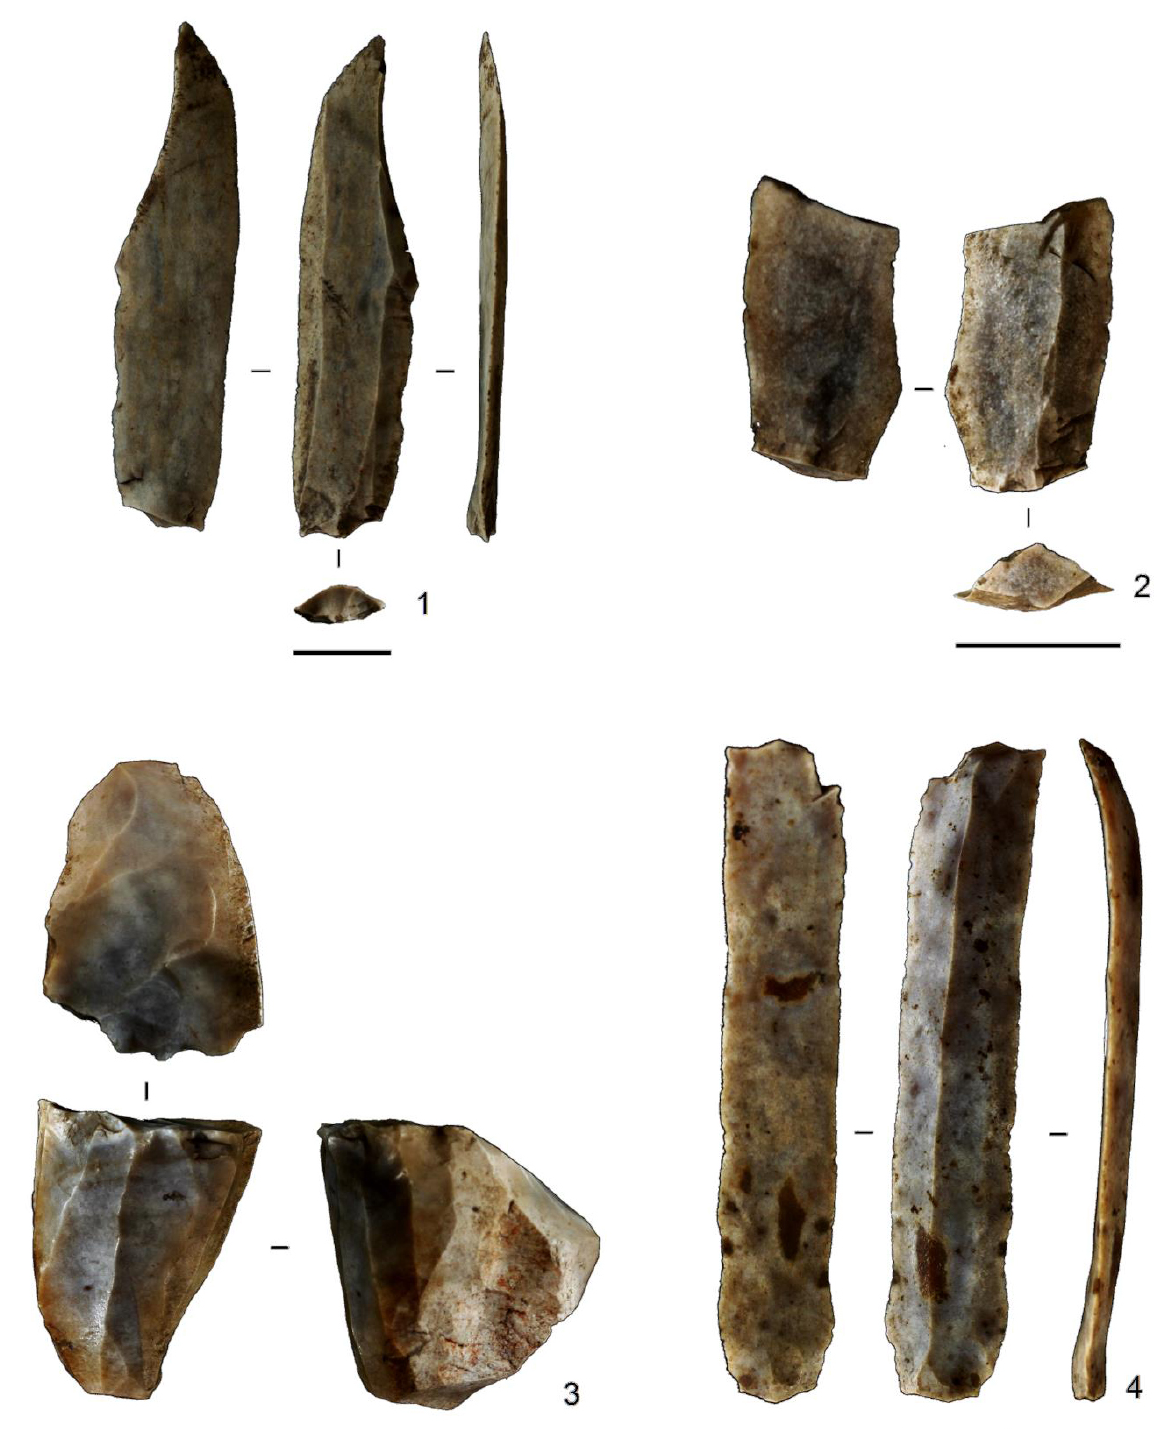
Figura 5. Exemplos de núcleo e lamelas do Meu Jardim. 1. 1: lamela inteira com talão diedro (Sondagem 1, Fase III); 2: lamela de fratura proximal com talão liso (Sondagem 1, Fase III); 3: núcleo prismático para lamelas com plataforma facetada (Sondagem 3, UE 3030, Fase IV); 4: lamela inteira, não retocada, de talão liso (Sondagem 3, Fase II). (barras = 1 cm). Figure 5. Examples of core and bladelets from Meu Jardim: 1: complete bladelet with dihedral butt (Test 1, Phase III); 2: proximal bladelet with flat butt (Test 1, Phase III); 3: prismatic core for bladelet production, with facetted platform (Test 3, Phase IV); 4: complete bladelet, unretouched, with flat butt (Test 3, Phase II). (bars = 1